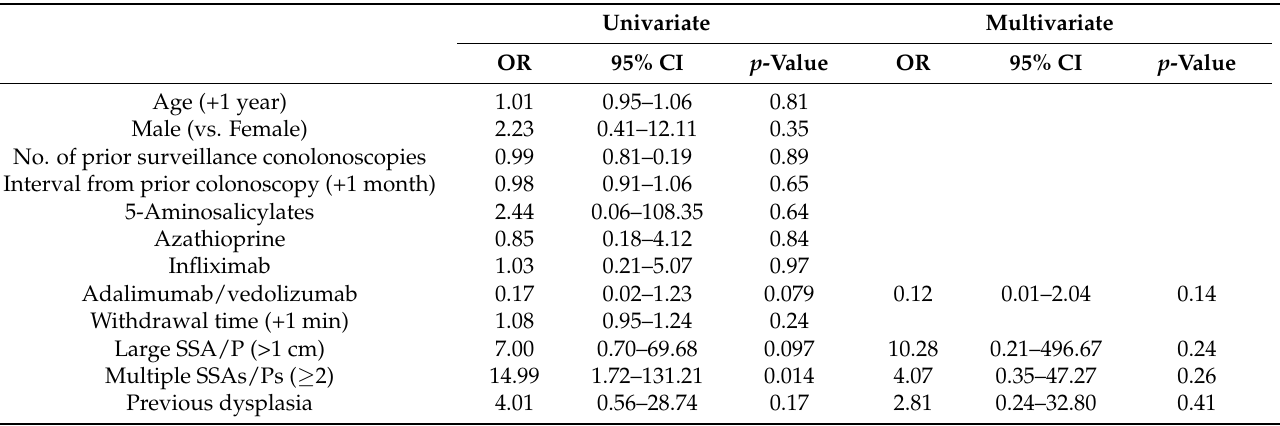
Table 5. Univariate and multivariate logistic regression analysis for factors associated with missed dysplasia and/or sessile serrated adenoma/polyps